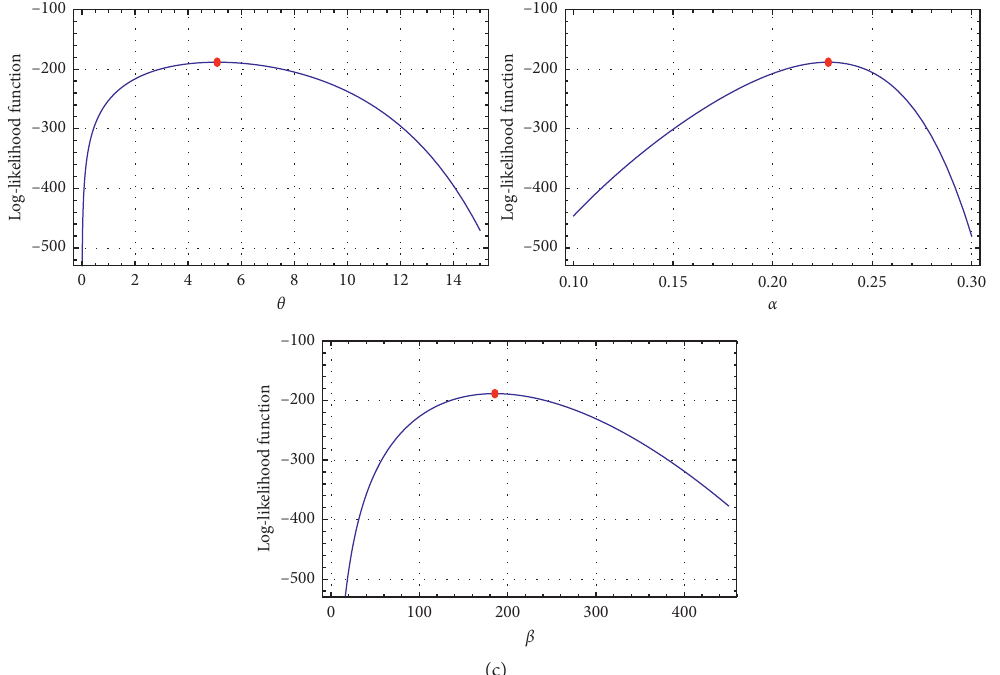
Figure 6: (a) Plots of the estimated pdf and cdf for data set II. (b) Plots of the estimated sf and PP plot for data set II. (c) Log-likelihood plots for data set